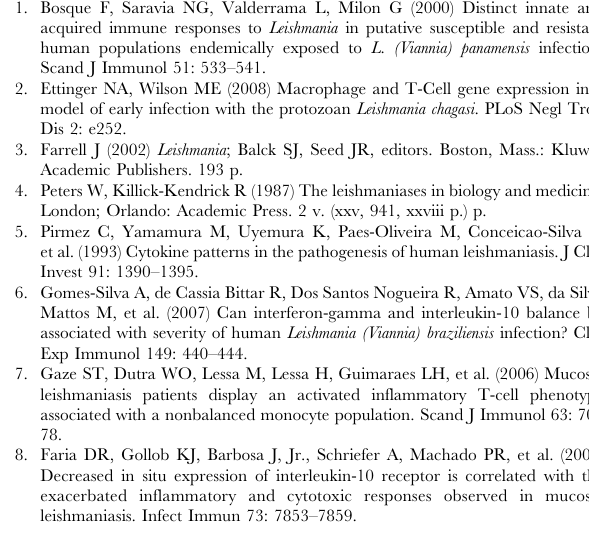
Table S2 Consistently up- and down-regulated genes. Shown are the level of gene expression, gene bank number and gene description of the annotated genes that were consistently up- regulated and down-regulated at all time points during the first 24 hours of infection (p , 0.05, average of the responses of MDM of 6 individuals examined). Genes are organized based upon the relative gene expression at 0.5 hour post-infection/interaction, from highest to lowest. Table S3 Pathway analyses of human macrophage response to L. (Viannia) panamensis infection. Shown are the results from statistical analyses of cellular pathways activated over the first 24 hours of infection. Five pathways were consistently activated throughout the first 24 hours of infection: (1) eicosanoid